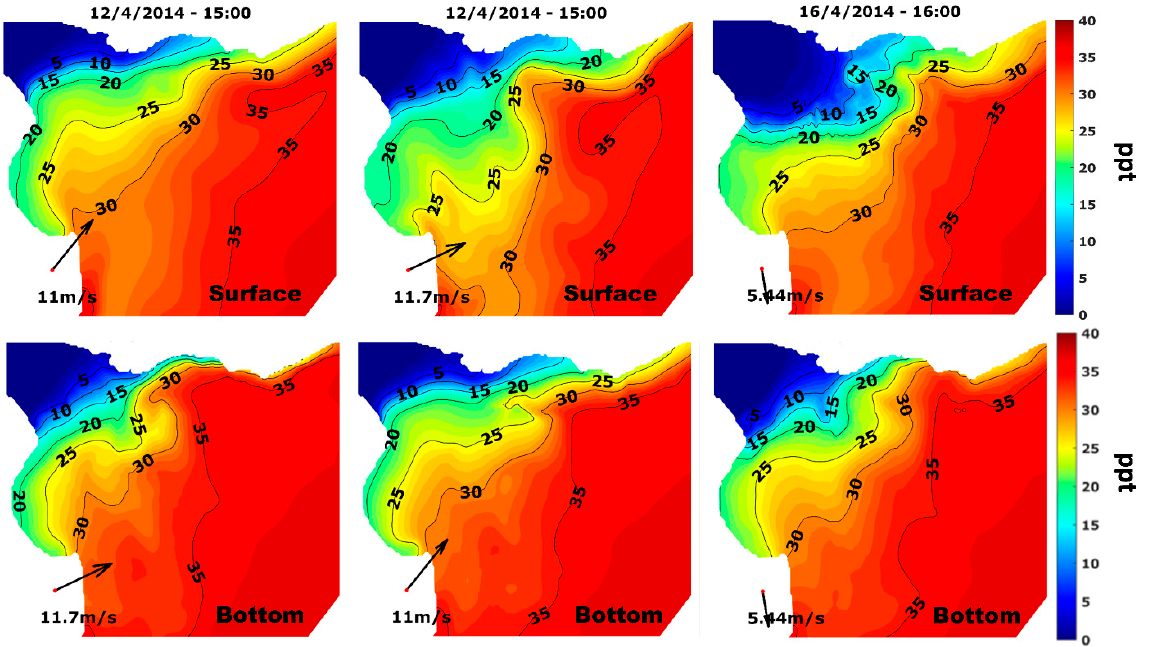
Figure 9. Bottom (upper panels) and surface (lower panels) salinity fields (ppt) for the southwest storm (April 2014) before the storm (left panels), a few hours after the peak of the storm (central panels), and two days after the storm (right panels). All maps are in geographic coordinates between Lat ( − 36.9, − 34.7) and Long ( − 57.4, 54.2).